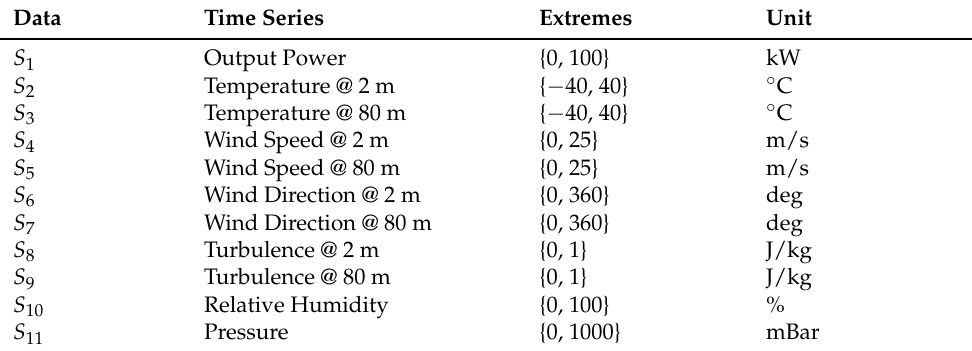
Table 1. Attributes of time series